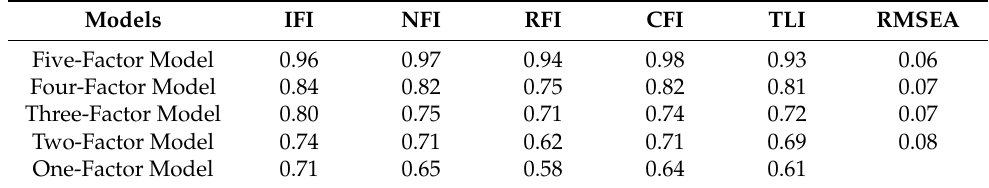
Table 2. Confirmatory factor analysis.